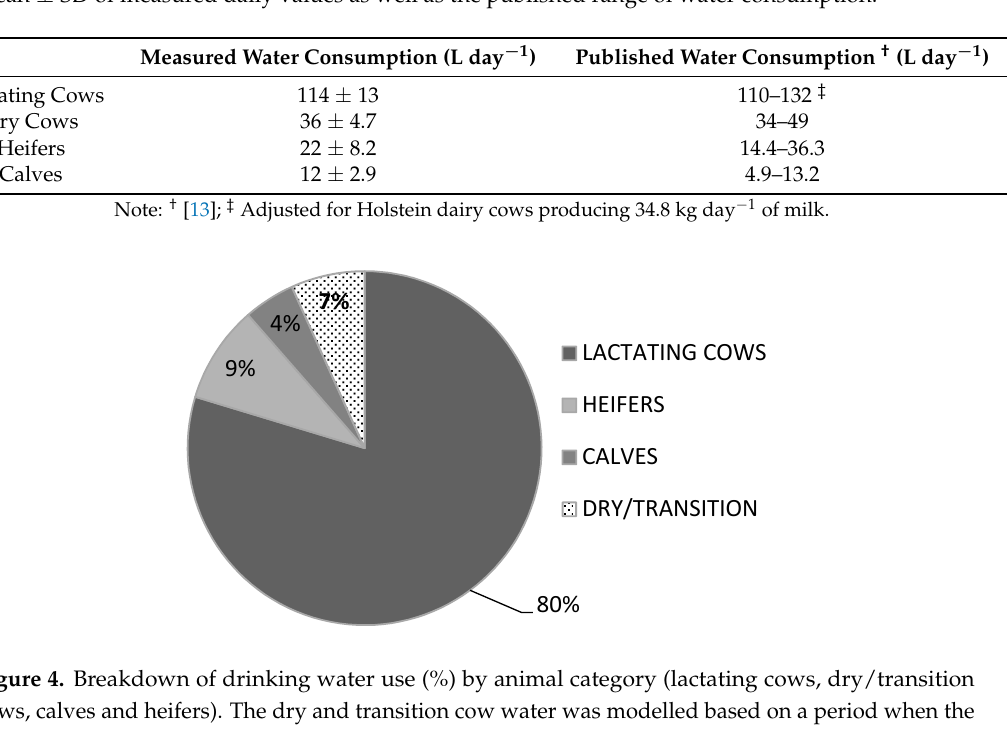
Table 3. Measured and published water consumption per animal category (L day − 1 ) showing the mean ± SD of measured daily values as well as the published range of water consumption.